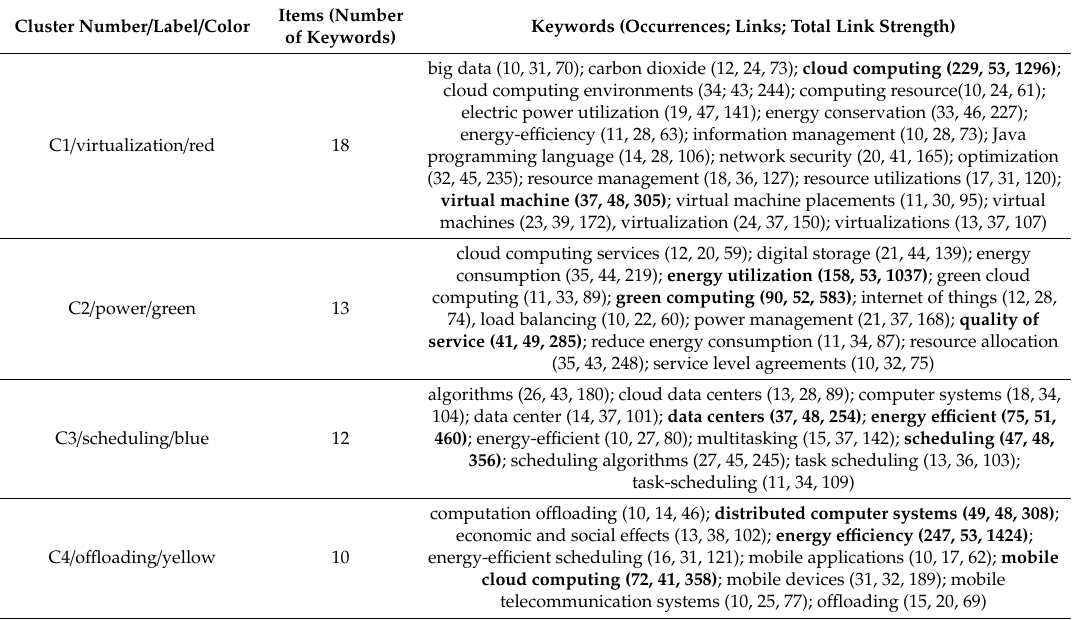
Table 6. Structure of thematic clusters in research on cloud computing energy e ffi ciency. Items (Number Keywords (Occurrences; Links; Total Link Strength) Cluster Number / Label / Color of Keywords)